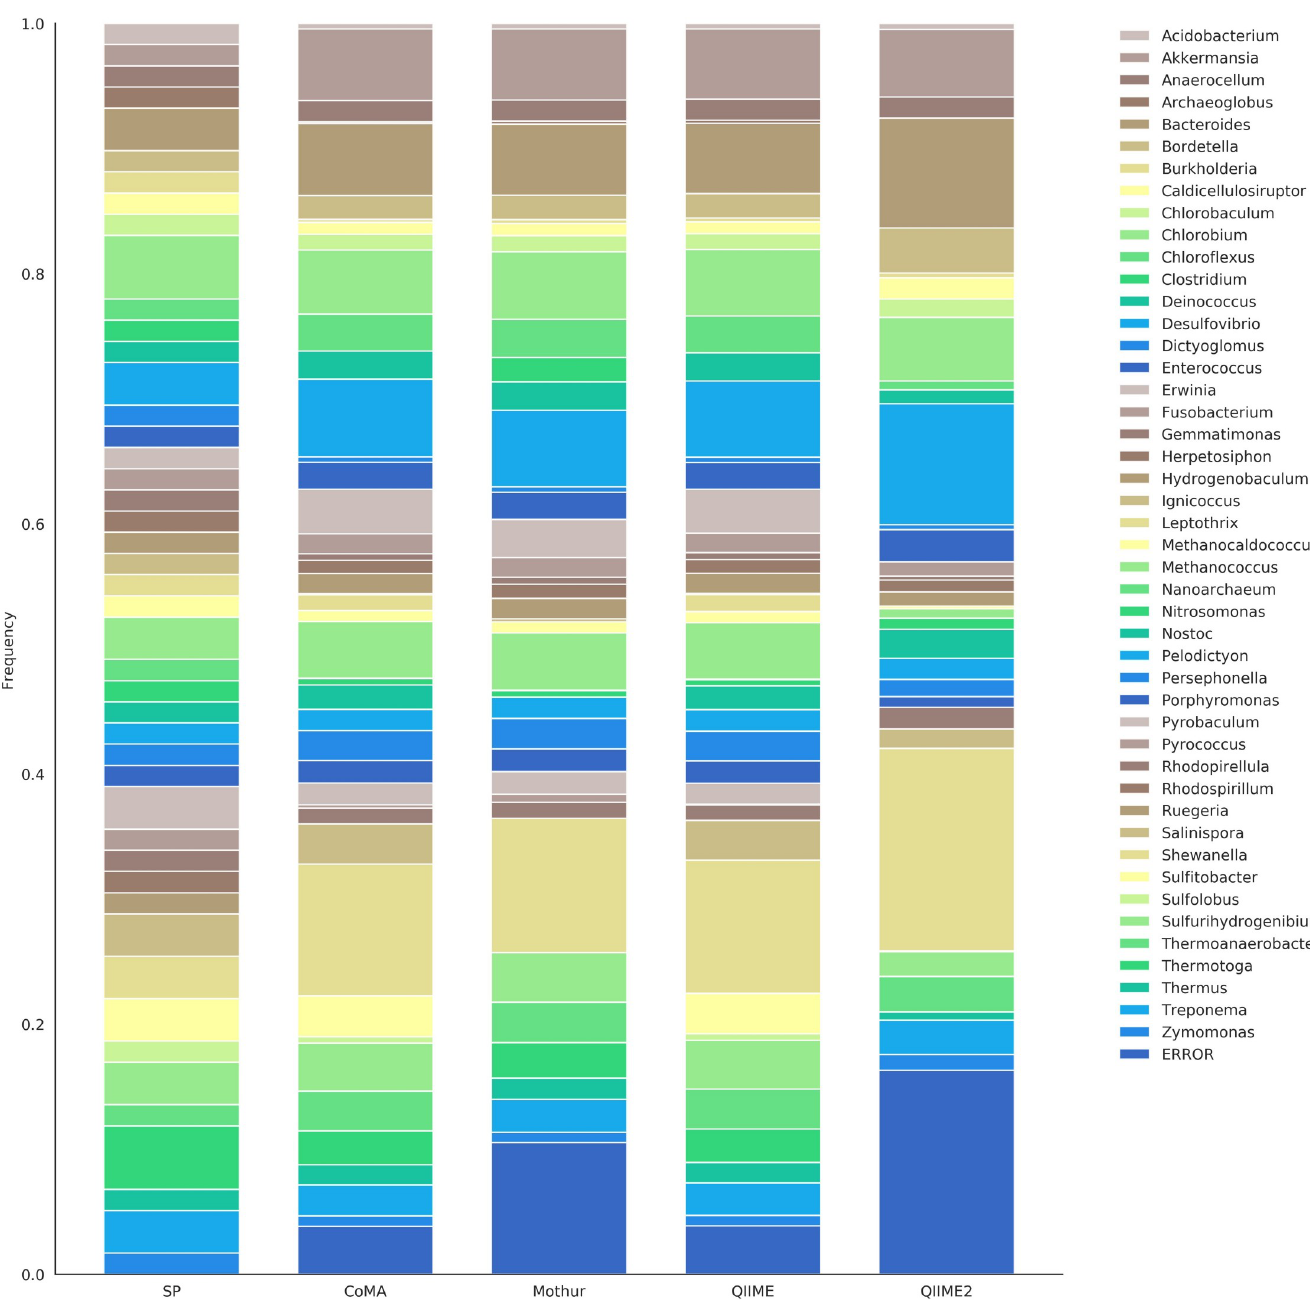
PLOS ONE | https://doi.org/10.1371/journal.pone.0243241 December2,